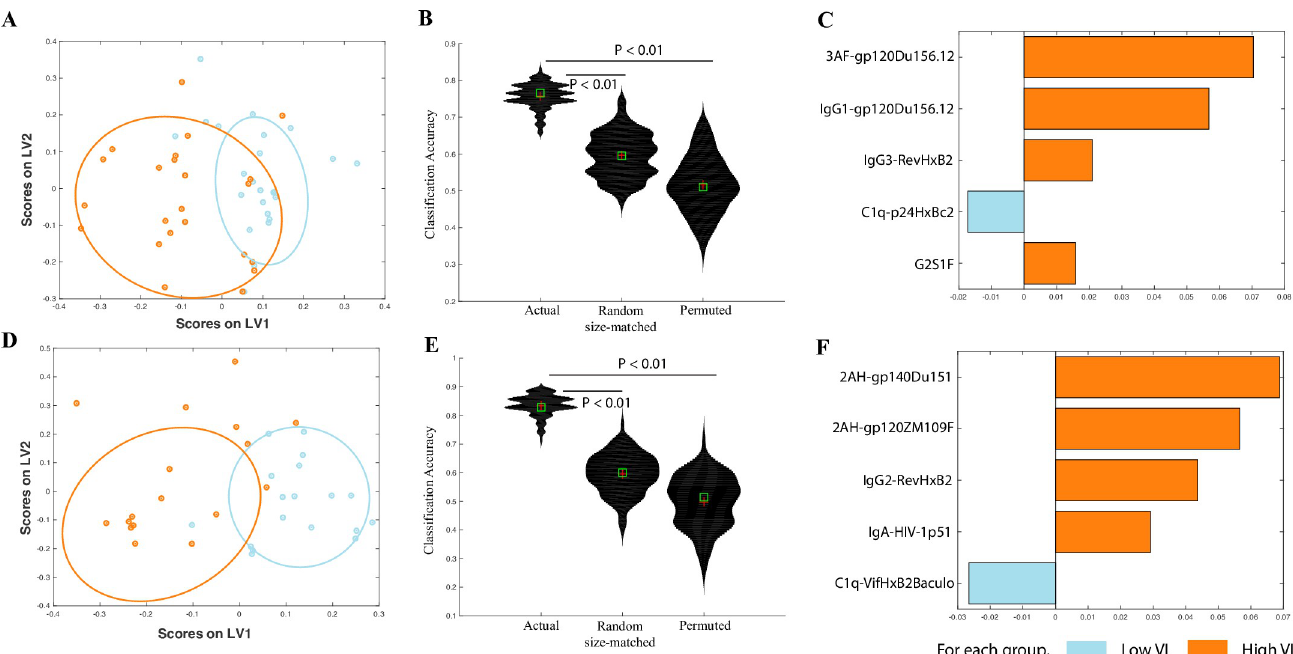
Fig 2. Correlates of viral load in controllers and chronic progressors. A. A LASSO-based model is used to classify controllers and progressors by viral load. The LASSO-selected features are visualized in 2 dimensions using a partial least squares discriminant analysis (PLSDA) latent variable (LV) scores biplot. B. Violin plots showing classification accuracy of the actual model from (a) and of 2 negative control models (based on randomly selected features & permuted data), as measured in a 5-fold cross validation framework. Exact P values (actual vs permuted and actual vs random-size matched) confirm significance of the model. C. PLS variable importance in the projection (VIP) plot corresponding to the features in (a) used to classify subjects by viral load. D. A LASSO-based model is used to classify only controllers by viral load. The LASSO-selected features are visualized in 2 dimensions using a PLSDA LV scores biplot. E. Violin plots showing classification accuracy of the actual model from (d) and of 2 negative control models (based on randomly selected features & permuted data), as measured in a 5-fold cross validation framework. Exact P values (actual vs permuted and actual vs random-size matched) confirm significance of the model. F. PLS VIP plot corresponding to the features in (d) used to classify subjects by viral